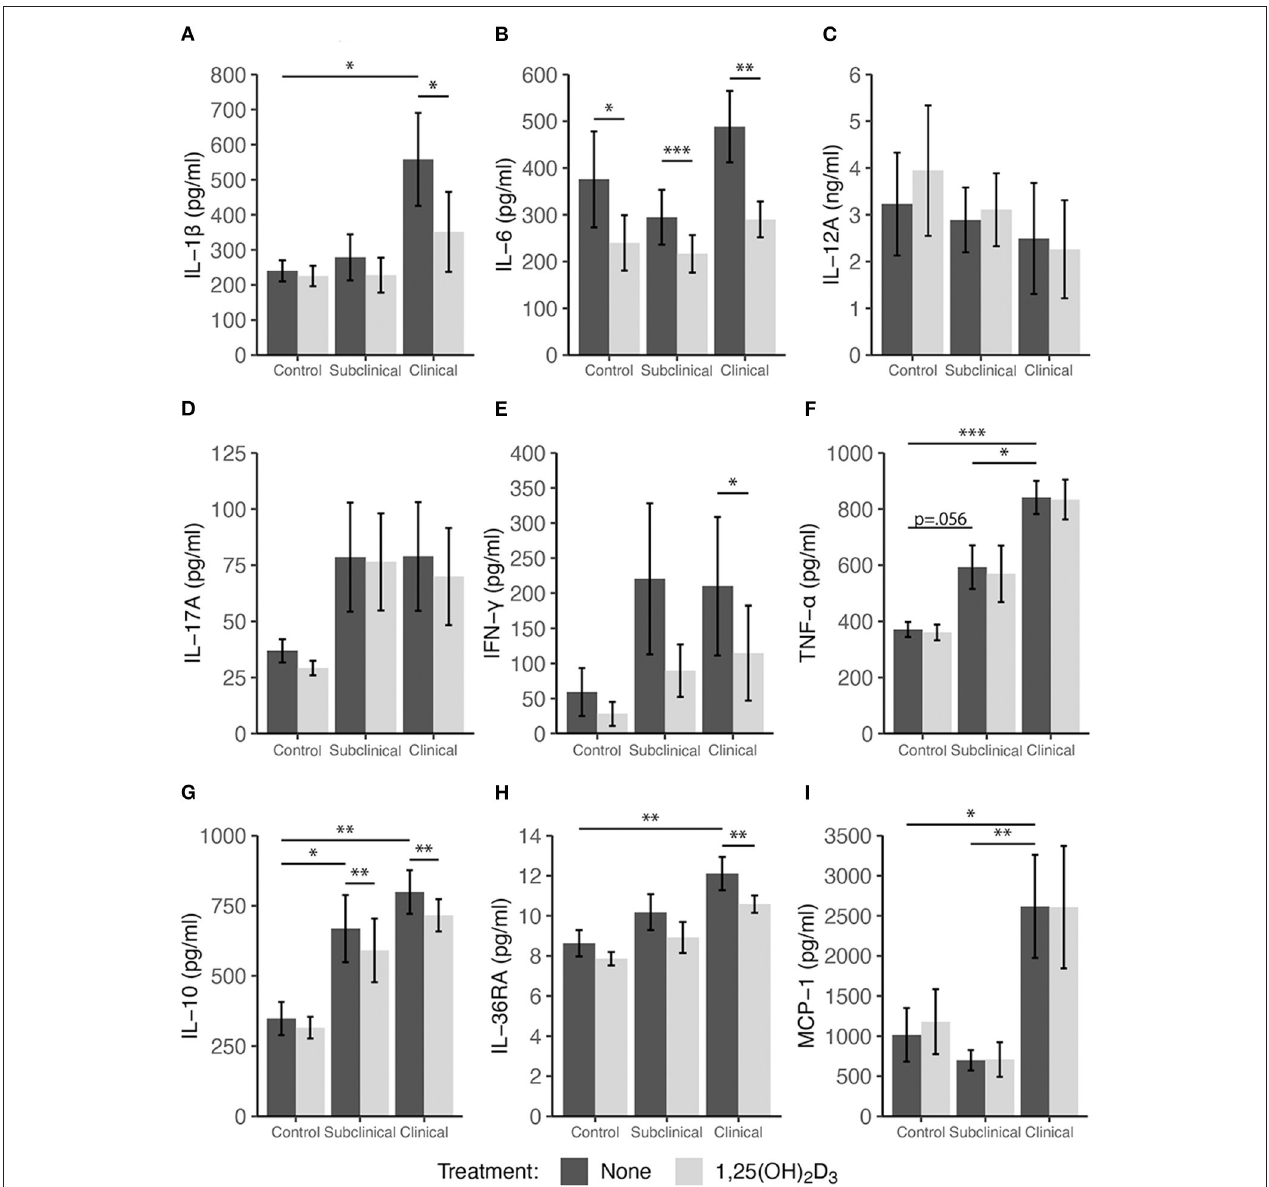
FIGURE 2 | Secretion of cytokines by PBMCs isolated from naturally infected dairy cattle (subclinical n = 8, clinical n = 8) or non-infected controls ( n = 8). Peripheral blood mononuclear cells were cultured 24h with whole cell MAP sonicate (MPS) ± 4ng/ml 1,25(OH) 2 D 3 . Cell culture supernatants were incubated overnight with cytokine specific magnetic beads for (A) IL-1 β , (B) IL-6, (D) IL-17A, (E) IFN- γ , (F) TNF- α , (G) IL-10, (H) IL-36RA, and (I) MCP-1 supplied in the Milliplex bovine multiplex assay. Fluorescence was measured using the Luminex MAGPIX xMAP instrument and cytokine concentrations were determined by standard curve. Standard ELISA was used to measure (C) IL-12A concentrations. Data are presented as the mean ± SE and significance levels are as follows: * < 0.05, ** < 0.01, *** < 0.001.